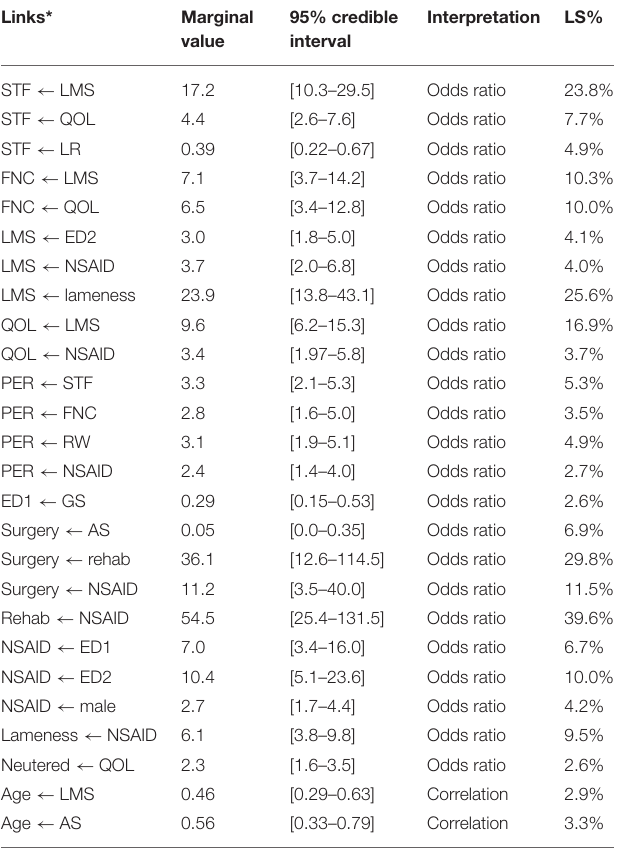
TABLE 5 | Estimates of the marginal posterior densities (median and 95% credible interval) and link strength percentage (LS%) for the variables included in the model.